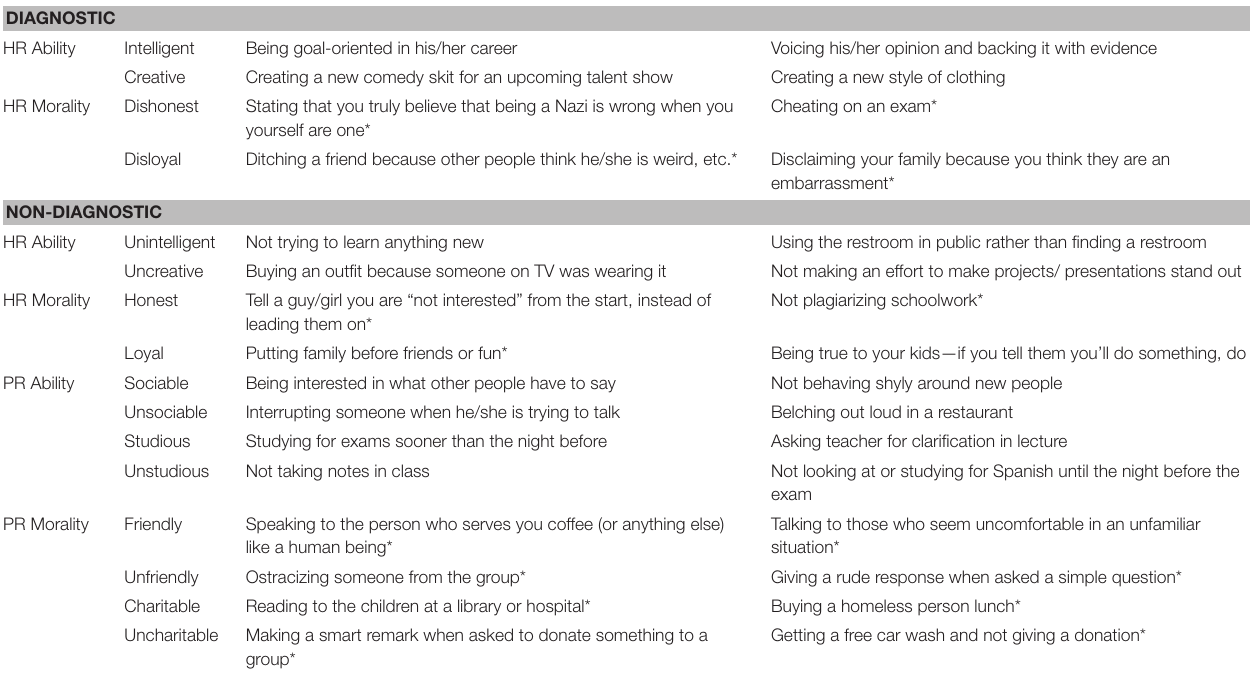
TABLE 2 | Behavioral stimuli based on category—ability/morality,